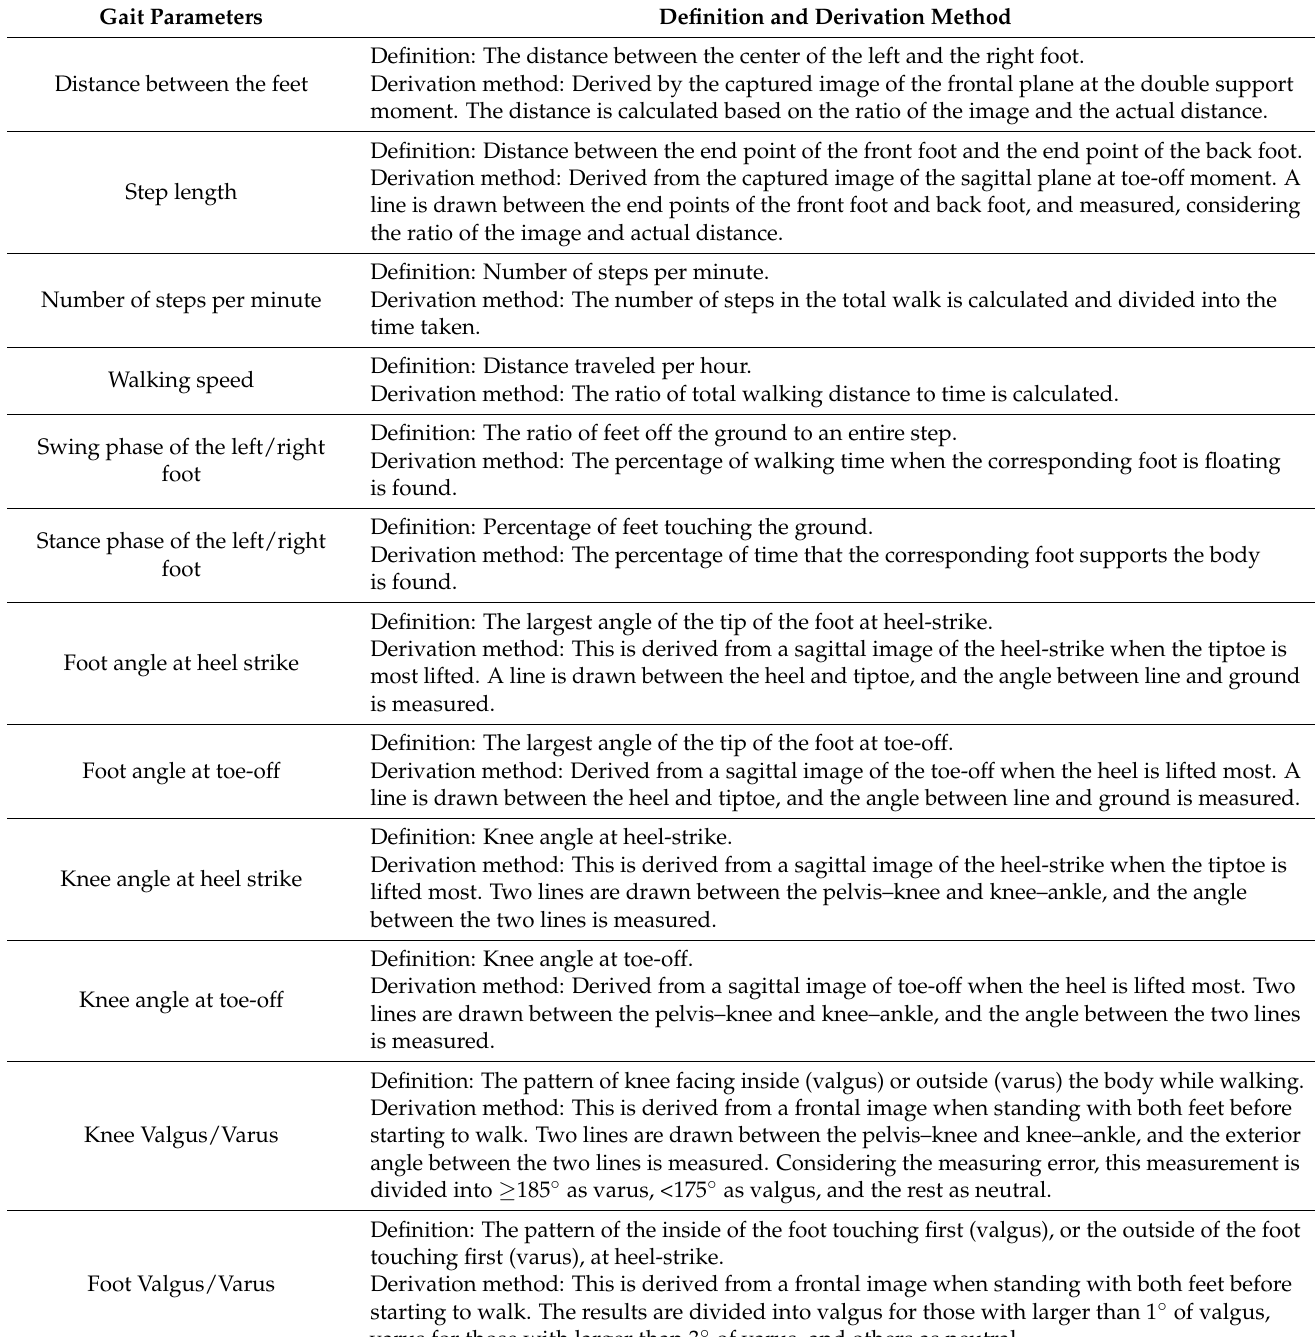
Table 3. Definition and derivation method of gait parameters of the lower body (Adapted from Lee et al. 2022 [14], Ergonomic Society of Korea, 2016 [15]). Gait Parameters Definition and Derivation